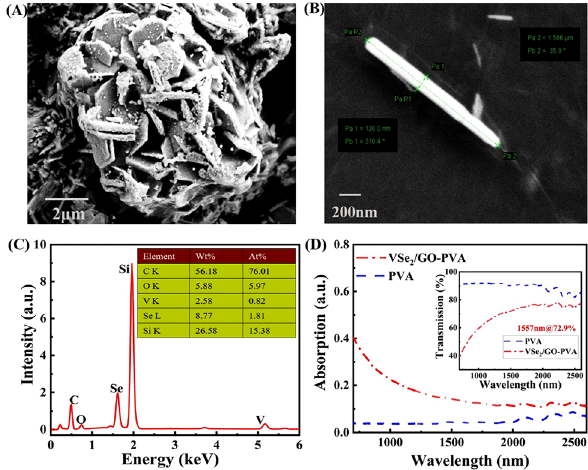
Figure 2: Characterization and measurement of materials. (A, B) SEM image of VSe 2 /GO. (C) EDS spectrum of VSe 2 /GO nanosheet. (D) Linear absorption spectrum of VSe 2 /GO SA. (Inset: the nonlinear optical absorption properties of VSe 2 /GO).